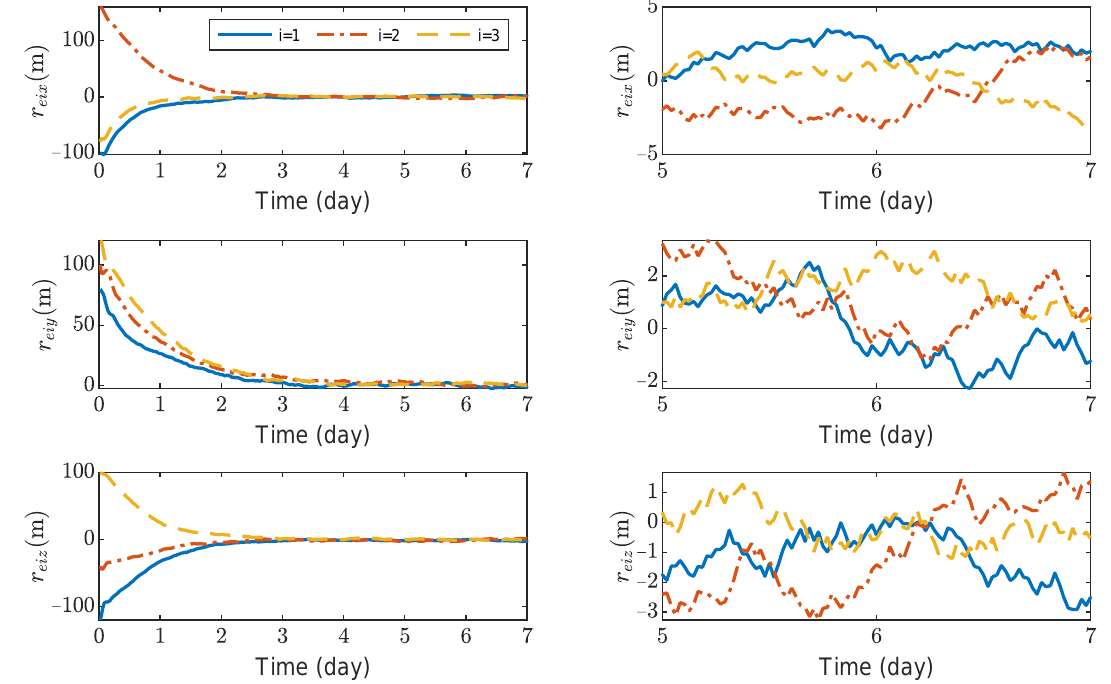
Figure 3. Relative position errors of spacecraft SC1 ∼ 3, the max control force of spacecraft is 100 µ N.